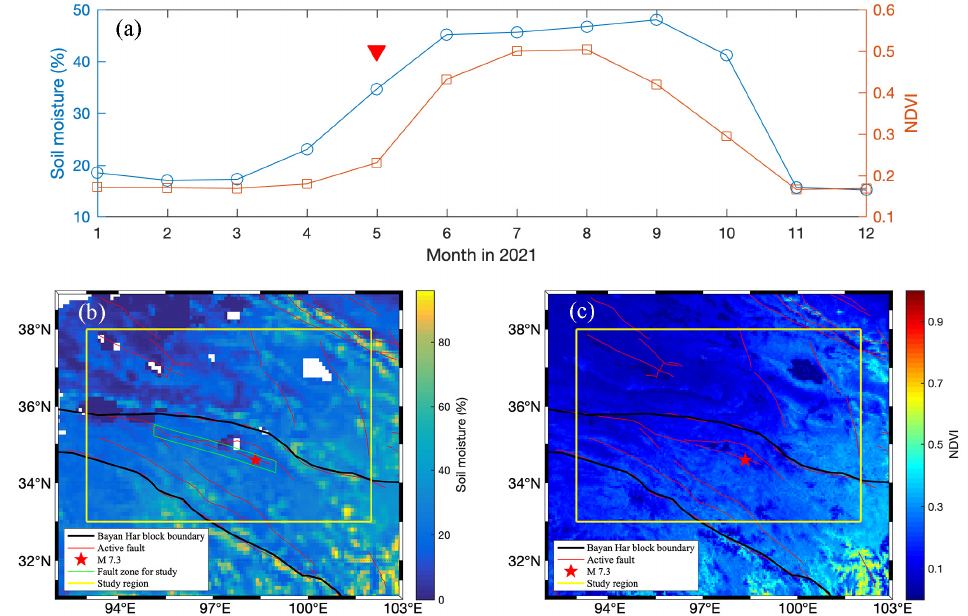
Figure 2. Spatio-temporal distribution of soil moisture and NDVI. ( a ) Monthly area-averaged (5° × 5°) variations in the soil moisture and NDVI around the epicentral region in 2021. The red triangle indicates the month in which Madoi earthquake occurred. ( b ) Five-month-averaged soil moisture in epicentral region from January to May 2021. ( c ) Five-month-averaged NDVI in epicentral region from January to May 2021.